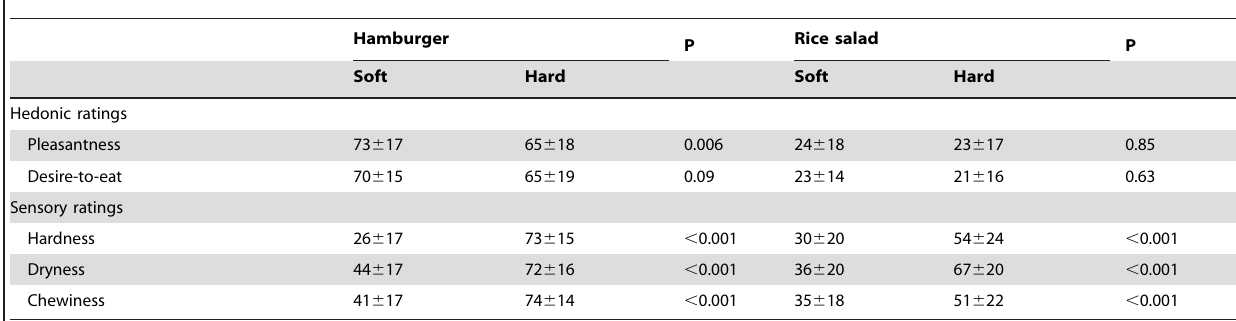
Table 3. Hedonic and sensory ratings of the foods. 1